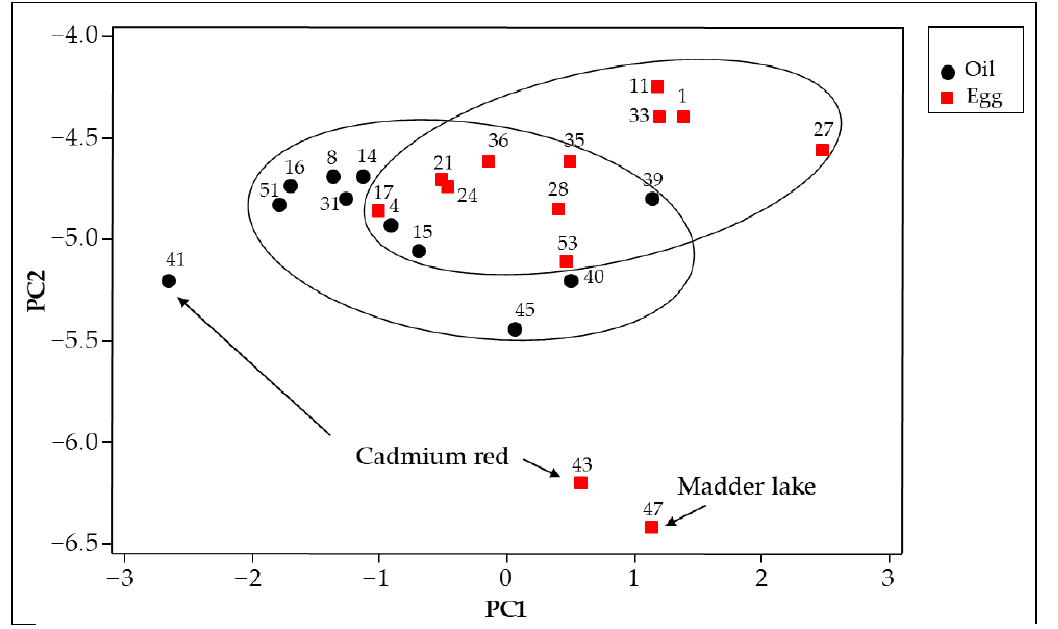
Figure 5. Score plot of the first two principal components of the emission spectra ( λ exc = 365 nm) of pictorial layers with egg tempera and oil as binders, mixed with different pigments (explained variance 89.3%). For the numbering of the samples, see Table 1.